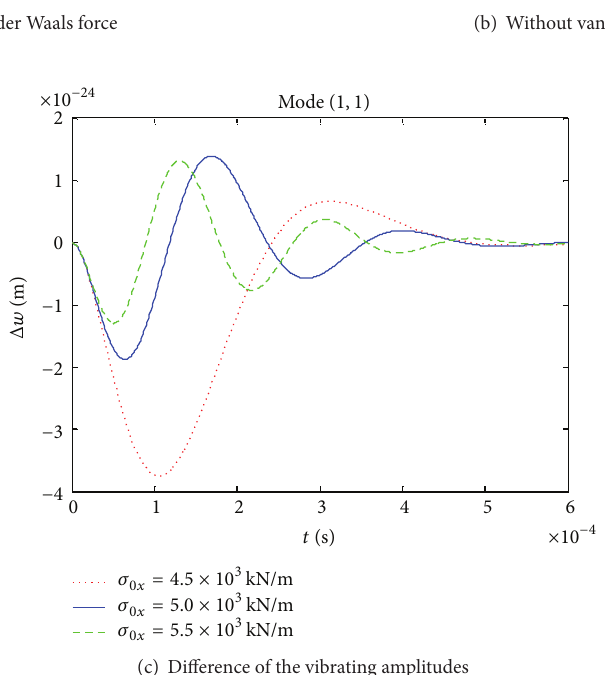
Figure 5: Effects of the van der Waals force on vibrating amplitude of the film center for various 𝜎 0𝑥